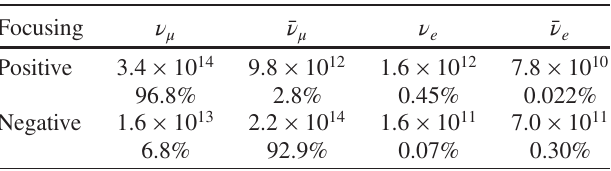
TABLE VIII. Integral neutrino flux per year for each flavor at a distance of 100 km over a surface of 100 m 2 . The fluxes were obtained with a sample of 10 7 simulated proton-target inter-